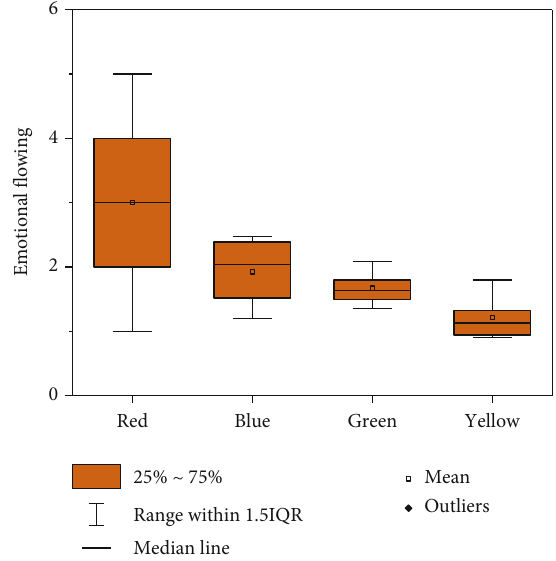
Figure 5: Color scenes and emotional